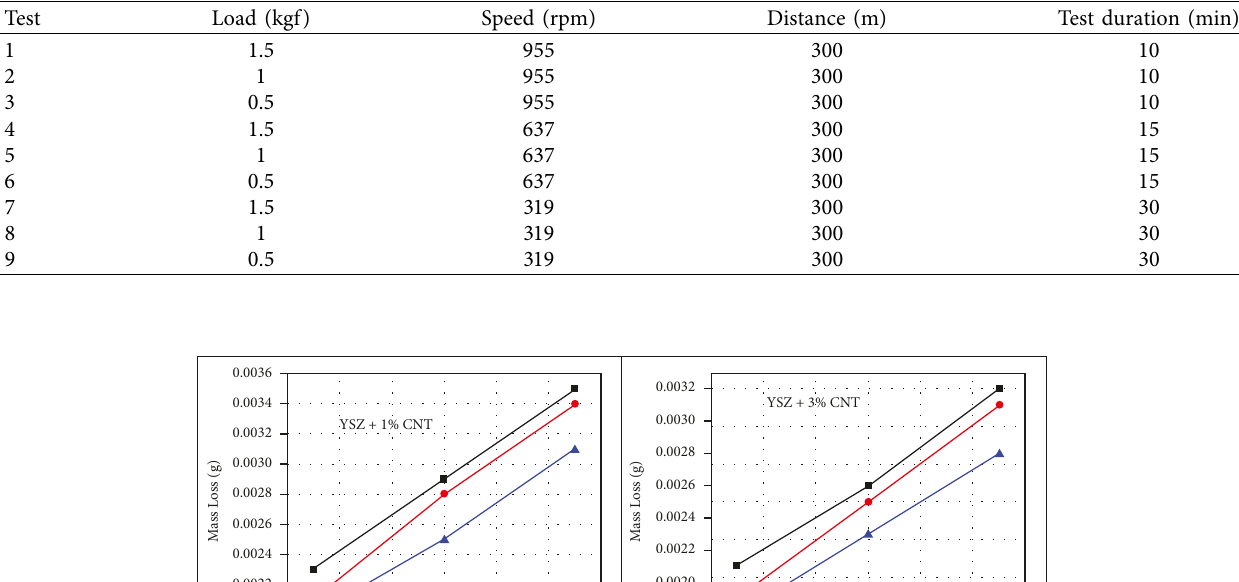
Table 4: Combination of test conditions used for wear test.